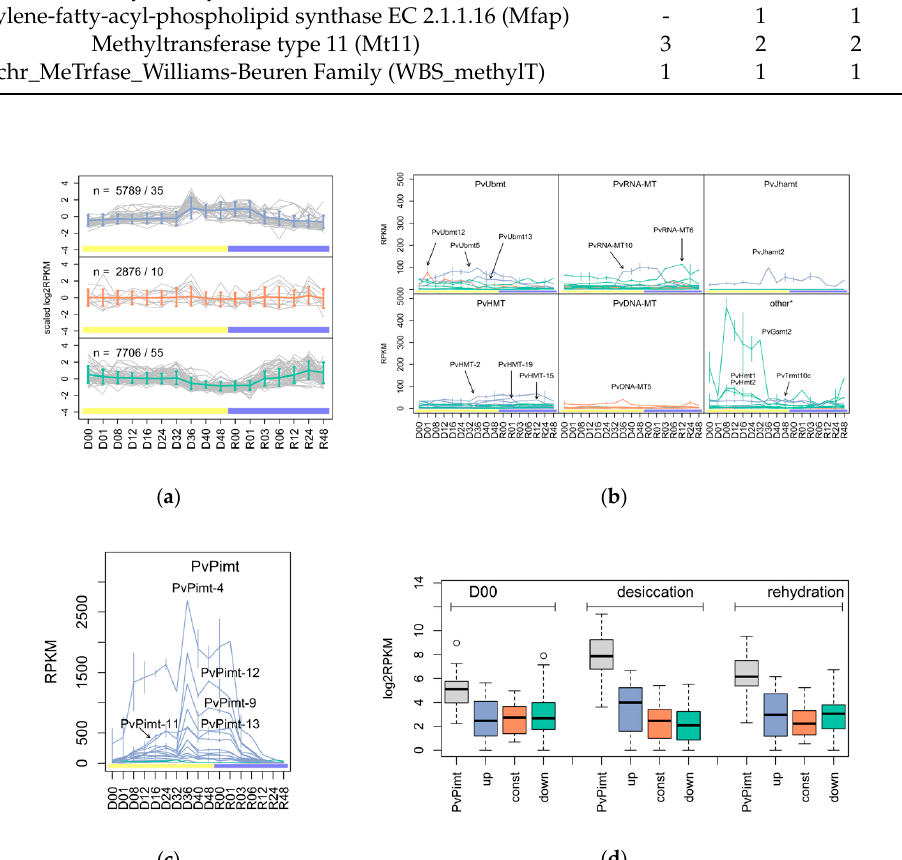
Figure 1. Expression profiling for defined SAM-dependent methyltransferases in desiccation (yellow)-rehydration (blue) experiments on P. vanderplanki larvae: ( a ) self-organizing maps (SOM) clustering of P. vanderplanki MTases into three groups, namely: upregulation (blue), stable (red), and downregulation trends (turquoise); n represents the number of genes/number of MTases in the group. ( b , c ) A view on the expression of different MTases by type. ( d ) Expression of PvPimt genes in comparison to other genes from defined clusters. D00—control, D01–D48—desiccation for 1–48 h (yellow bar), R00–R48—rehydration samples for 0–48 h (blue bar).